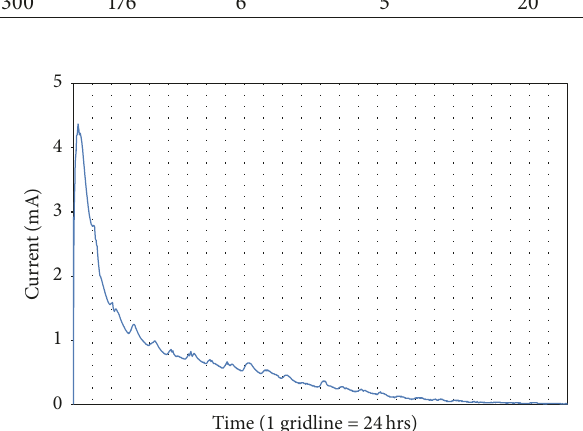
Figure 15: Final battery current discharge curve across 10 Ω resistor (note: this is not a logarithmic